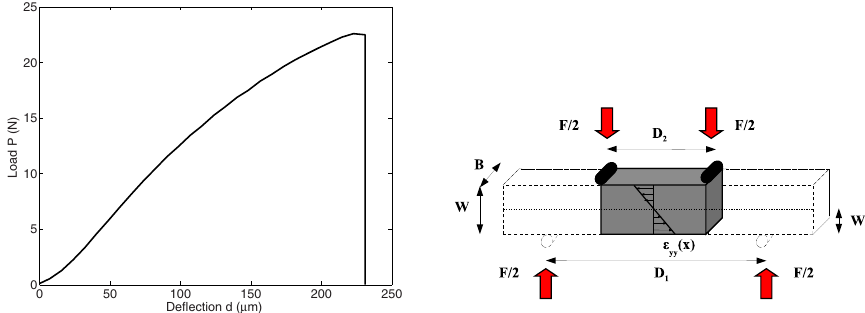
Figure 2. Experimental load-de(cid:13)ection curve for the four-point bending test on aluminium titanate at room temperature (left) - Neutral axis position according to the elastic linear hypotheses (right)